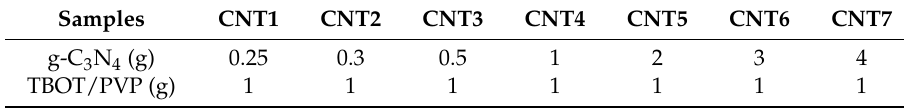
Table 1. Description of various as-prepared g-C 3 N 4 /TiO 2 (CNT)